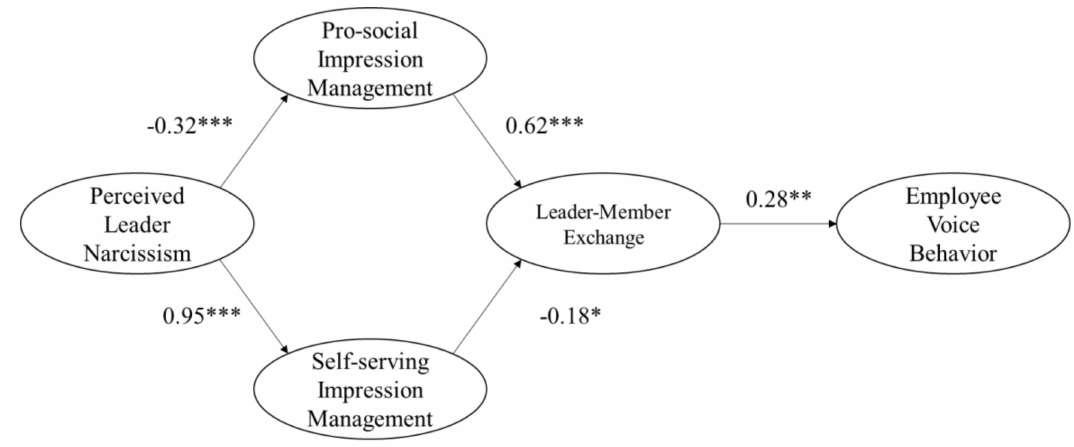
Figure 1. The path coe ffi cient of the hypothesis model. * p < 0.1; ** p < 0.05; *** p <